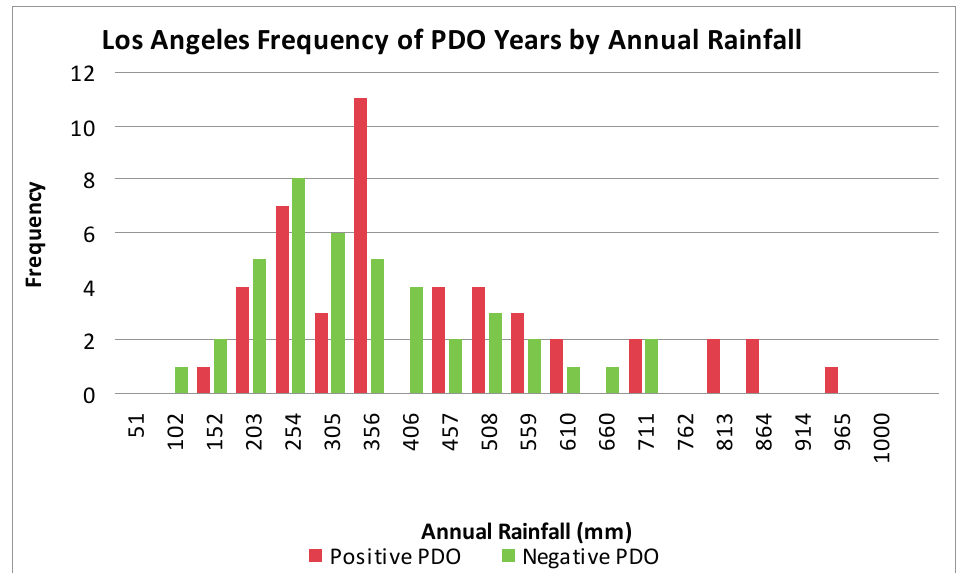
Figure 8. Frequency of PDO years versus annual rainfall for the Los Angeles station. Positive PDO years correspond with increased annual rainfall compared to negative PDO